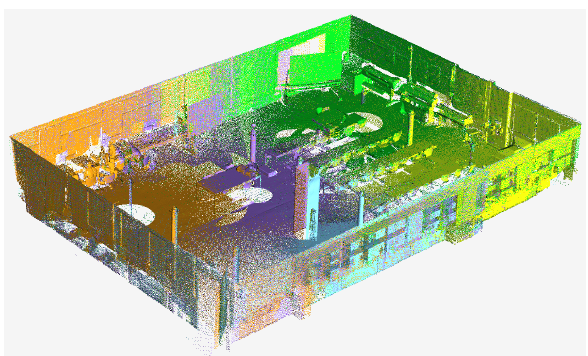
Figure 3: Office data set with five scans acquired in a standard office. For better visibility, the ceiling has been removed and only 33% of the points are displayed.